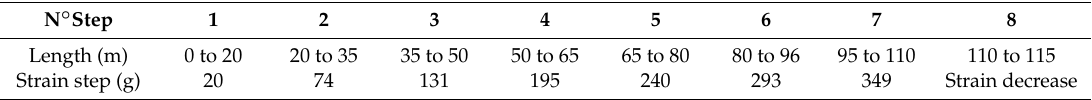
Figure 2. Schematic representation and picture of the strain calibration device.